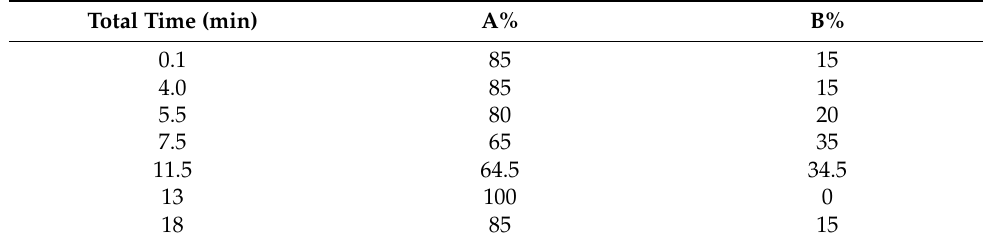
Table 2. Gradient separation